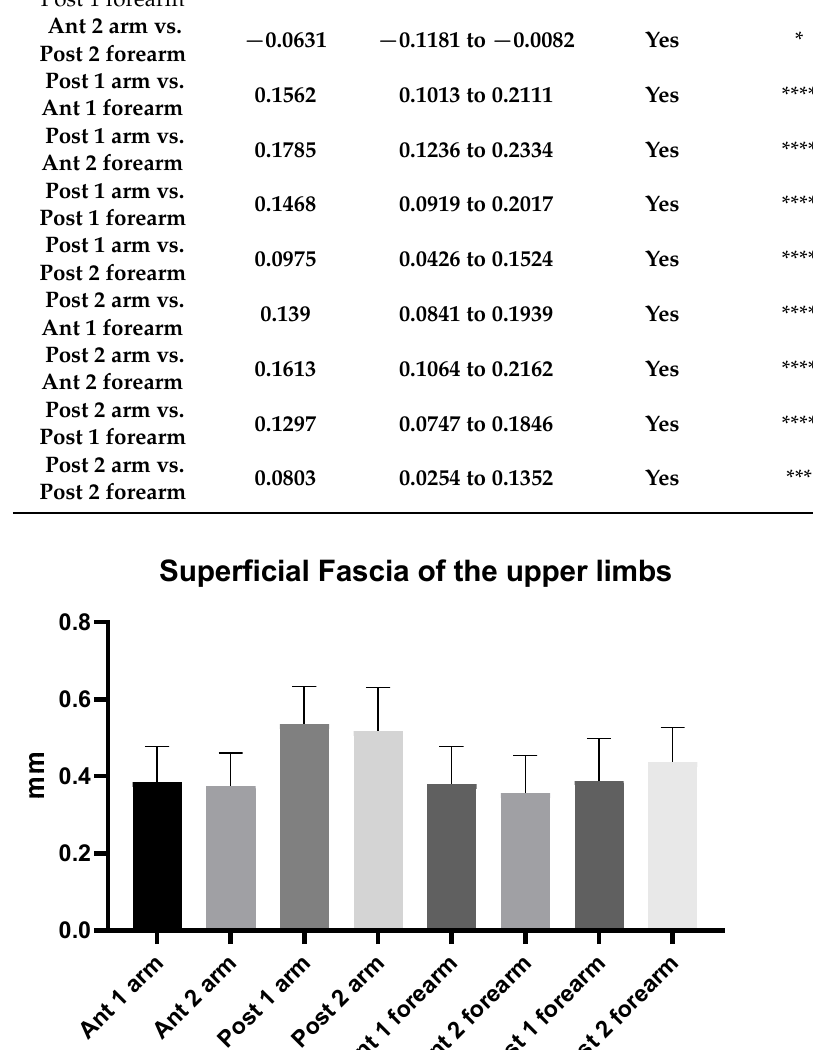
Table 6. Ultrasound measurements within different regions/levels of the superficial fascia of arm and of forearm. Statistically significant results are showed in bold. *: p < 0.05; **: p < 0.01; ****: p < 0.0001. ns: not statistically significant.